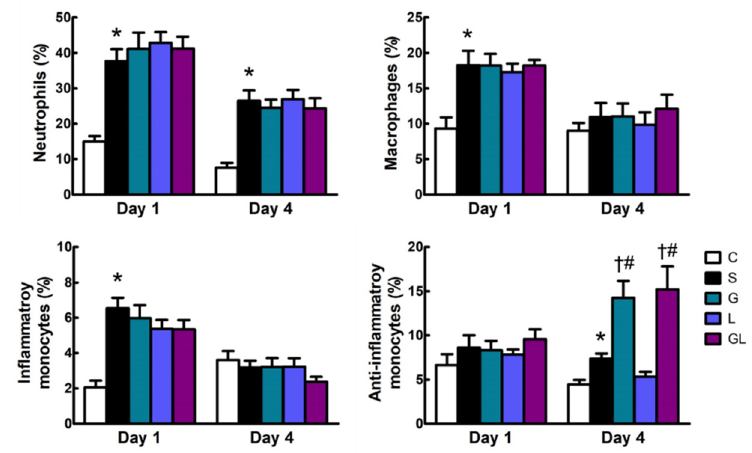
Figure 1. Blood leukocyte distribution. The groups are described in the legend to Table 1. Leukocyte populations are presented as the percentages of neutrophils (Ly6G + ), macrophages (F4/80 + ), inflam- matory monocytes (Ly6C high CCR2 + ), and anti-inflammatory monocytes (Ly6C low CX3CR1 + ) among blood leukocytes (CD45 + ). Student’s t -test was used to analyze differences between the C and S groups at the same time point. Differences among septic groups on the same day were analyzed by a one-way ANOVA with Tukey’s post-hoc test. * Significantly differs from the C group. † Significantly differs from the S group. # Significantly differs from the L group ( p < 0.05).